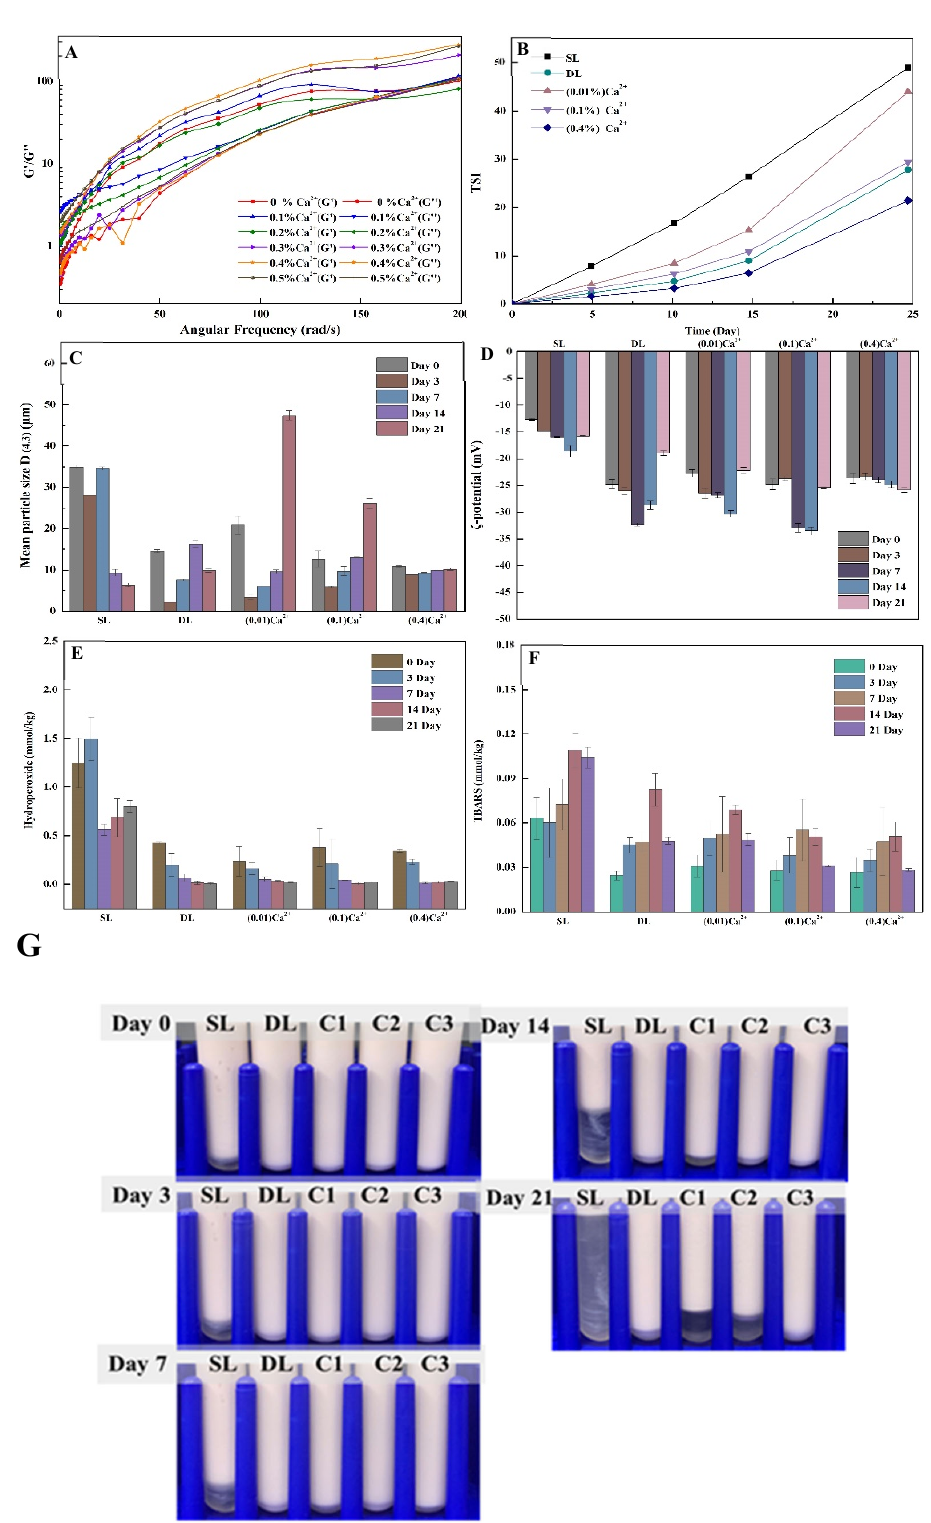
Figure 5. Effects of differences in calcium ion concentration of emulsions: ( A ) shear modulus versus frequency; stability of astaxanthin-loaded emulsion stored for 21 days: ( B ) TSI; ( C ) average droplet size; ( D ) ζ -potential; ( E ) hydroperoxide; ( F ) TBARS and appearance diagram (pH 5, 0.25 wt.%, PPI, 0.4 wt.% FG, 0.01, 0.1, 0.4 wt.% Ca 2+ ); ( G ) Appearance of emulsions loaded with astaxanthin during 21 days of storage (Day 0, 3, 7, 14, 21); SL, single-layer PPI emulsions; DL, PPI–FG (0.4%) double-layer emulsions system. ± standard deviations ( p <